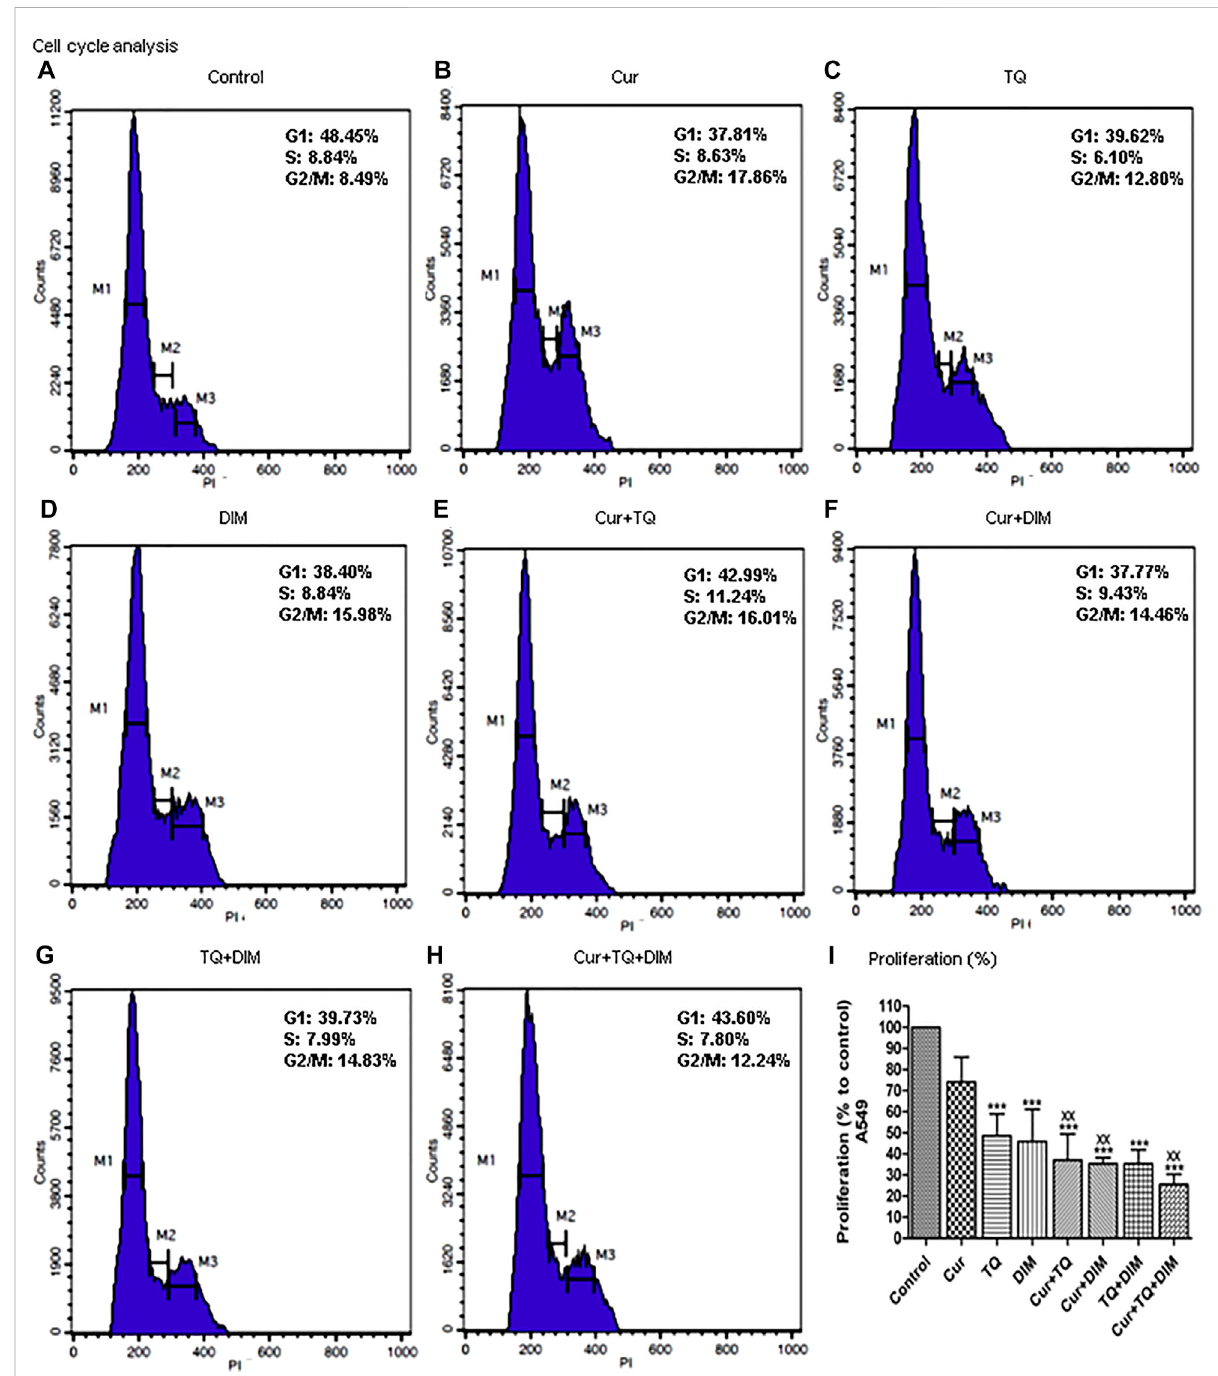
FIGURE 3 Cell cycle analysis and proliferation percentage of A549. (A) Cell cycle analysis of control A549. (B) Cell cycle analysis of Cur-treated cells with 0.75(Fa95)=9.53 µM. (C) CellcycleanalysisofTQ-treatedcellswith0.75(Fa95)=36.53 µM. (D) CellcycleanalysisofDIM-treatedcellswith0.75(Fa 95) = 47.65 µM. (E) Cell cycle analysis of Cur + TQ treated cells with 0.75 (Fa 95) of Cur and TQ. (F) Cell cycle analysis of Cur + DIM treated cells with 0.75(Fa95)ofCurandDIM. (G) CellcycleanalysisofTQ+DIMtreatedcellswith0.75(Fa95)ofTQandDIM. (H) CellcycleanalysisofCur+TQ+ DIM treated cells with 0.75 (Fa 95) of Cur, TQ, and DIM. (I) Proliferation percentages of control and A549-treated cells with 0.75 (Fa 95) of Cur, TQ, DIM, Cur + TQ, Cur + DIM, TQ + DIM, and Cur + TQ + DIM. The data were analyzed with one-way ANOVA followed by Tukey ’ s multiple comparison test. Error bars represent mean ± SD. *** p < 0.001 vs. control. xx P < 0.01 vs.